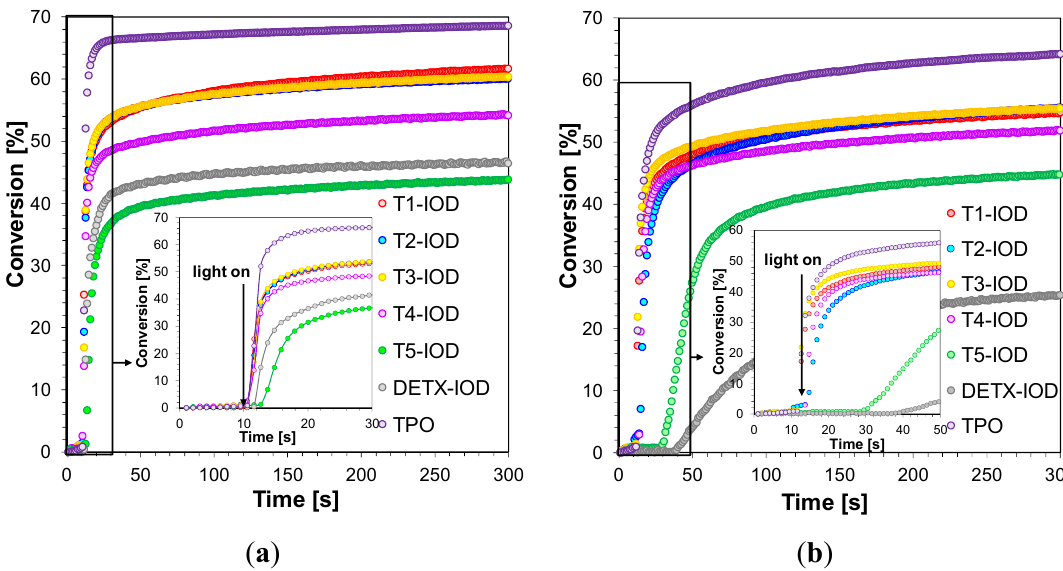
Figure 5. Polymerisation profiles of TMPTA (acrylate function conversion vs. irradiation time) in laminate in the presence of different photoinitiating systems based on IOD (1% w / w ) and 2,4-diethyl-thioxanthen-9-one derivatives (0.2% w / w ) upon exposure to ( a ) the visible LED@405 nm ( b ) to the visible LED@420 nm. The irradiation starts at t = 10 s. Table 3. Functional group conversions of acrylate monomer TMPTA using a photoinitiating systems based on 2,4-diethyl-thioxanthen-9-one derivatives (5.3 × 10 − 3 mol·dm − 3 , ~0.2 % wt.) and bis(4-t-butylphenyl)iodonium